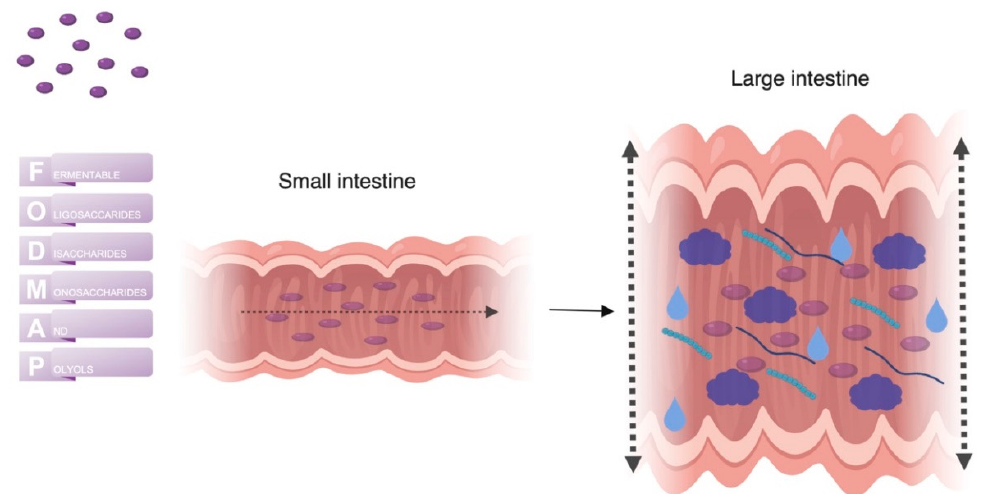
Figure 4. Mechanism of action of FODMAPs. When FODMAPs pass the small intestine where they are incompletely absorbed and can pass into the colon. In the colon the osmotically active short-chain carbohydrates increase the luminal water content. Fermentation of FODMAPs by colonic bacteria causes the production of gas. Increased luminal water content and gas production result in a distention of the large intestine, which in turn could generate GI symptoms. Abbreviations: FODMAPs: Fermentable oligosaccharides, disaccharides, monosaccharides and polyols; GI: gastrointestinal. Created with